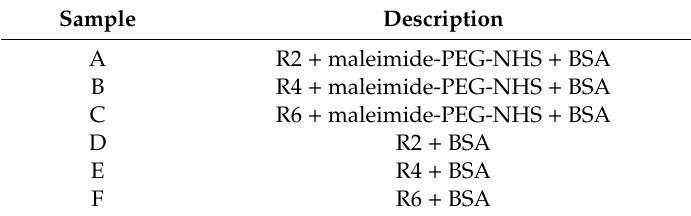
Table 4. Description of the samples submitted to cell uptake